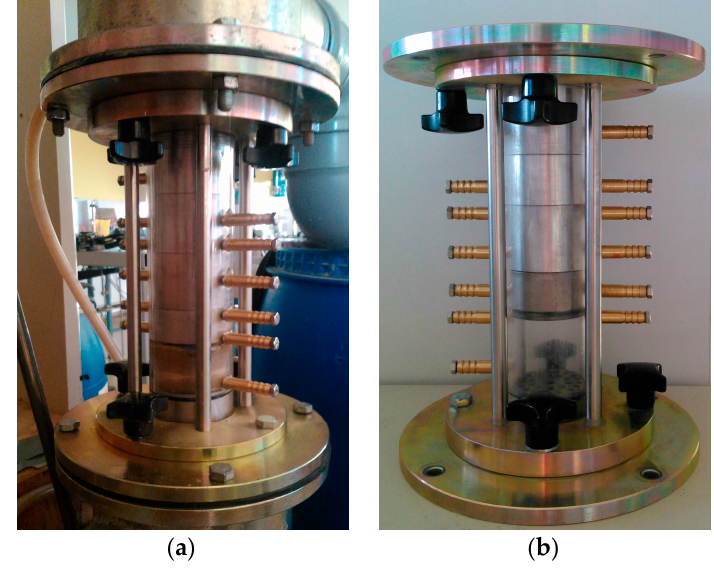
Figure 9. Central part of the laboratory equipment for a cyclic water flow test.